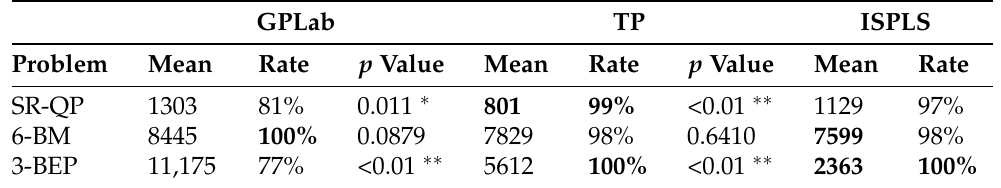
Table 4. Comparison of GPLab, TP and ISPLS algorithms under the same limitations on the number of fitness evaluations, where p > 0.05 means “not significantly different”, p < 0.05 ∗ means “significantly different”, and p < 0.01 ∗∗ means “highly